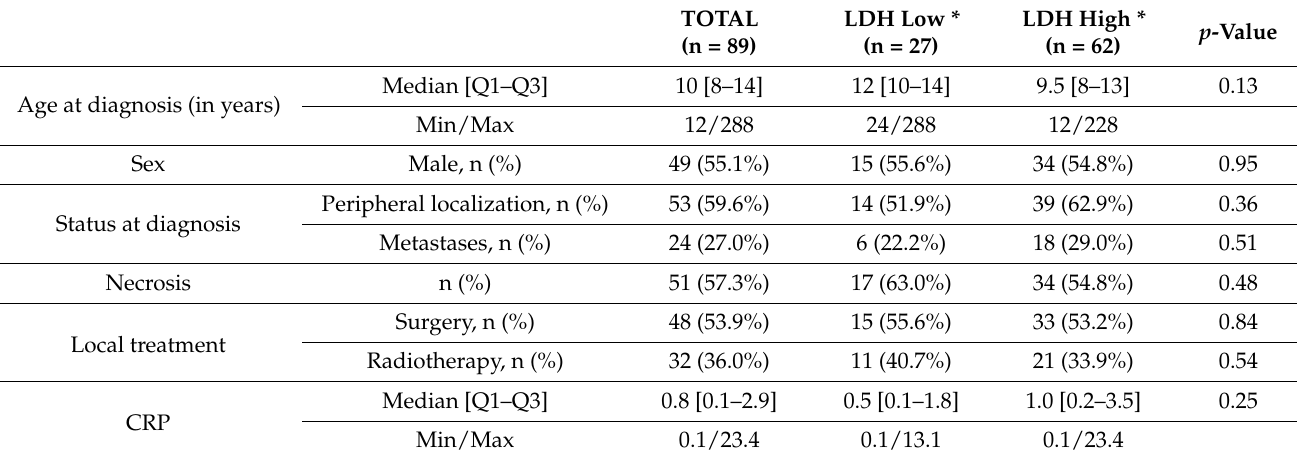
Table 3. Characteristics of patients according to the level of LDH at diagnosis.